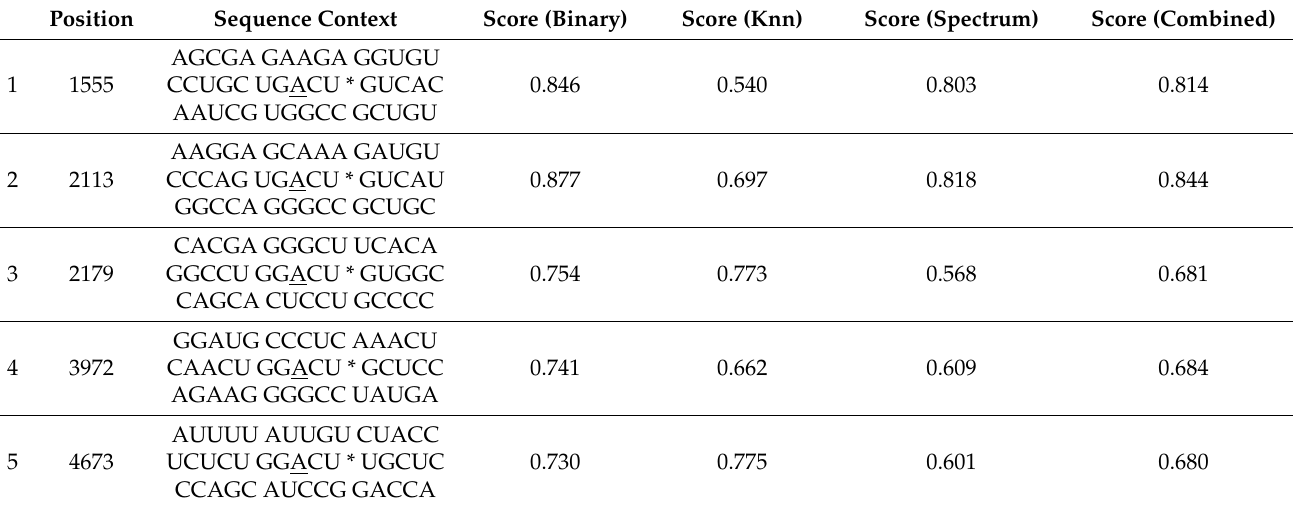
Table 2. The predicted m 6 A sites of TNC mRNA in human by SRAMP.